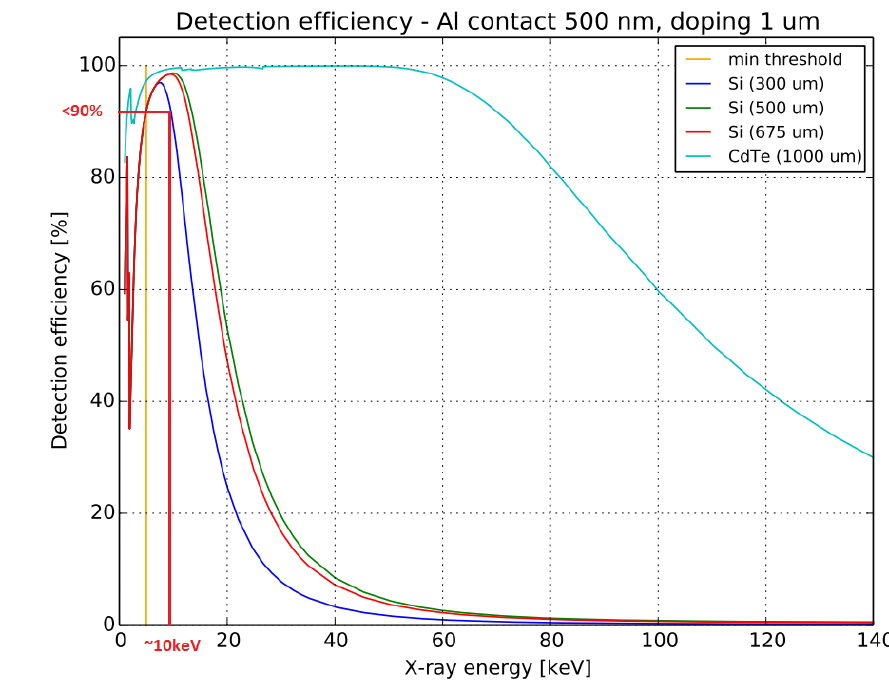
Figure 7. Pixel detector efficiency curve Reprinted with permission from [56] 2017 ADVACAM